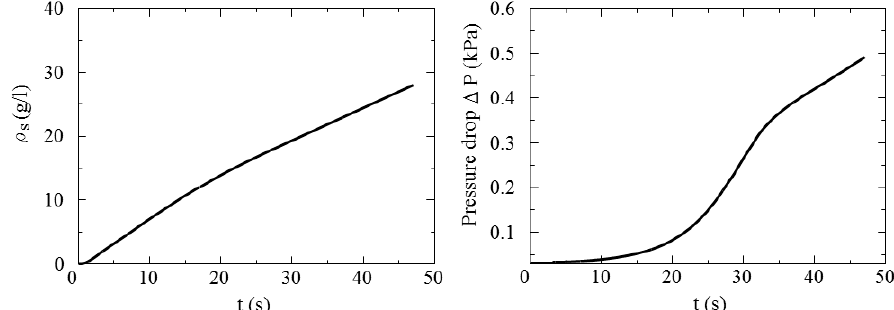
Figure 10. Time-variation of deposited soot mass ( left ) and pressure drop ( right ) in Filter 1.